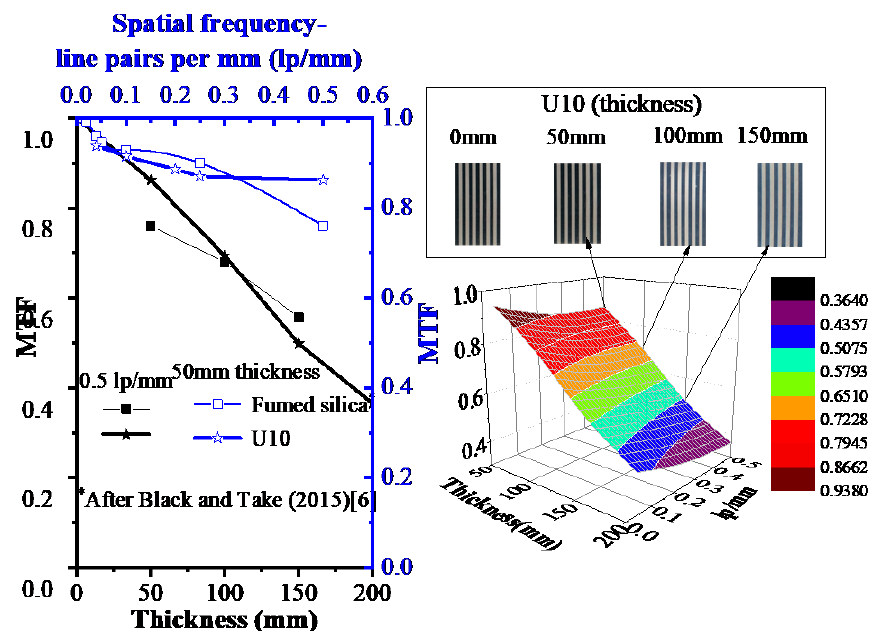
Figure 6. Transparency of materials versus soil thickness and spatial frequency by the MTF method.